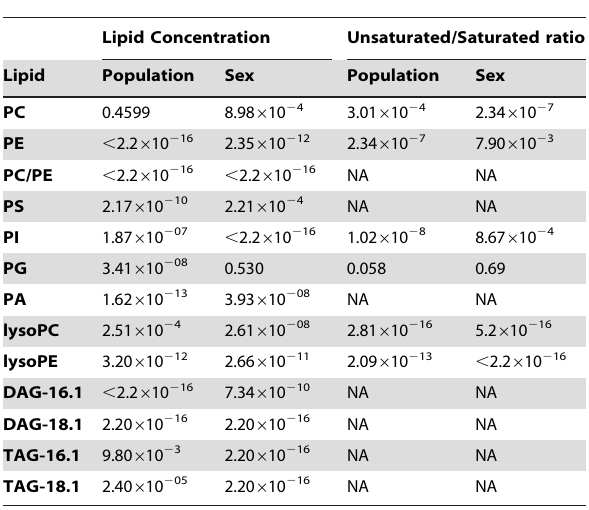
Table 1. ANOVA of lipid species by lipid class.